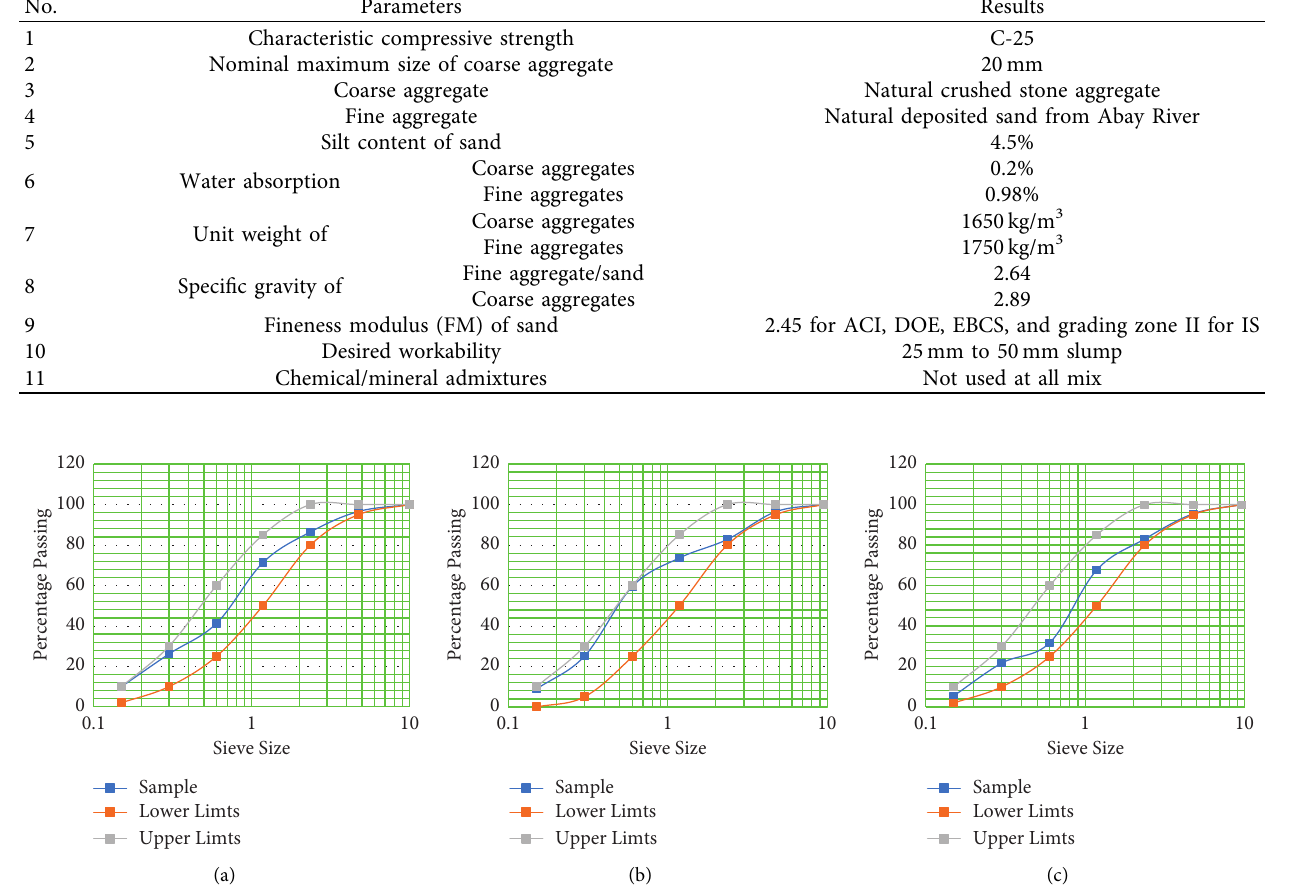
Figure 1: Fine aggregate gradation curves for selected